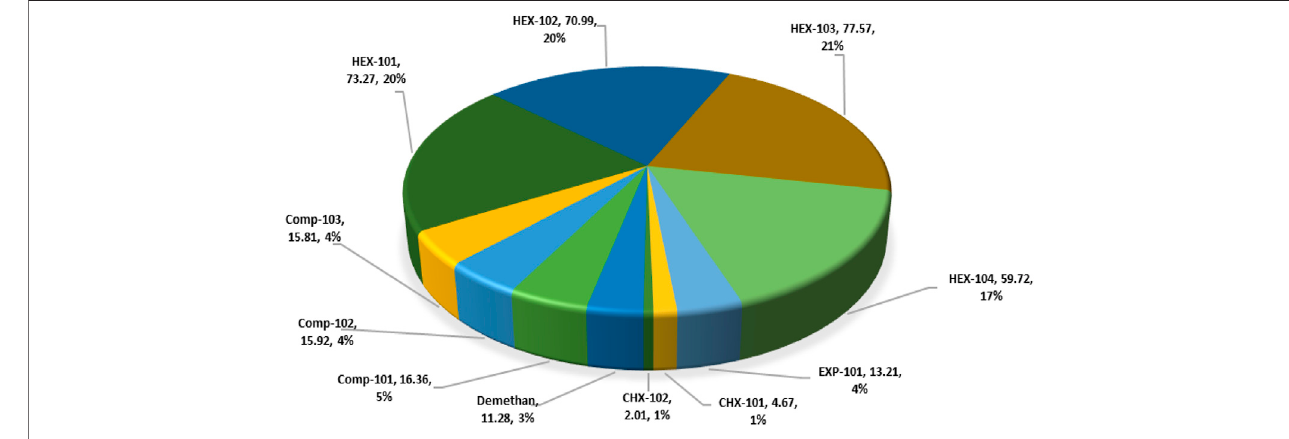
FIGURE 7 | Exergy destroyed in the NGL recovery process plant.